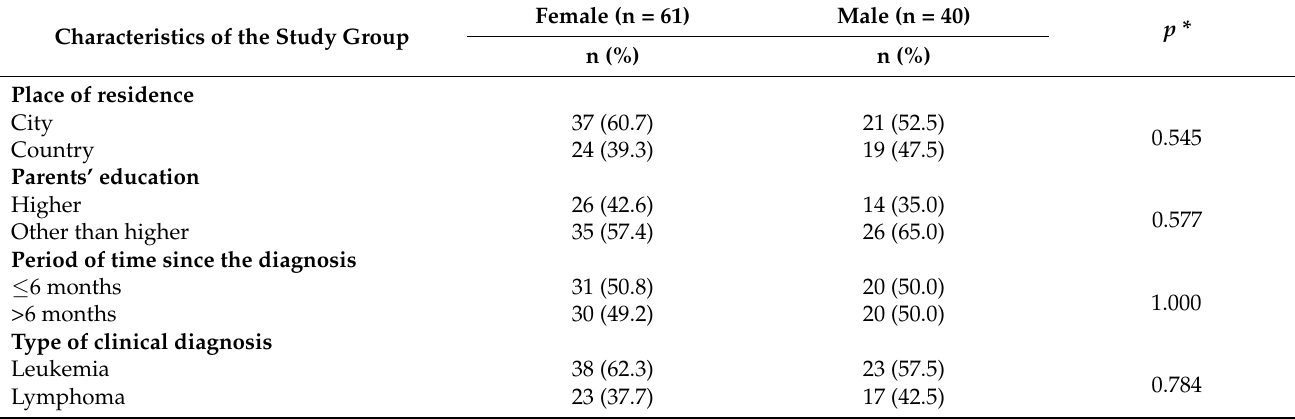
Table 1. Research group